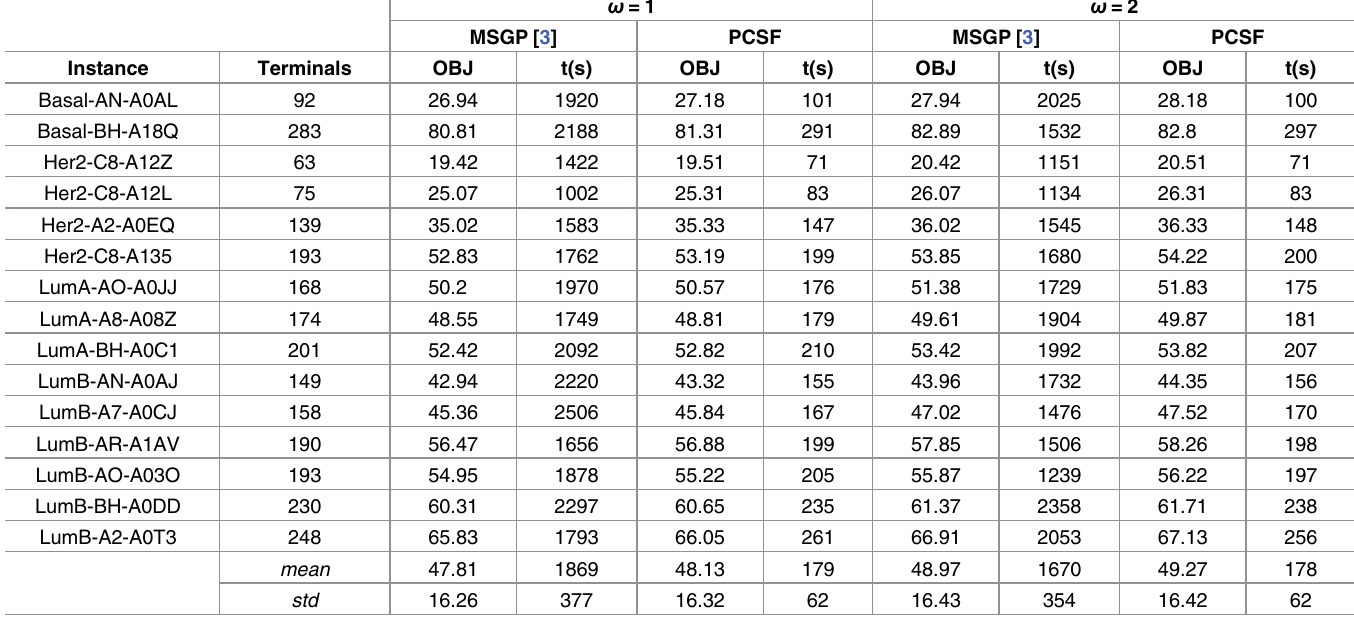
Table 1. The results of the methods for the BreastCancer network instances generated using the phosphoproteomic data in [11]. The performance of the message passingalgorithm[3] and the proposedmethod are respectivelydisplayedunder MSGP [3] and PCSF for ω = {1, 2}. The OBJ column reports the qualityof the solutions(objectivefunction values)obtainedby the methods, and the runningtimes of the algorithms are displayedunder t(s) in seconds. The averagestatistics of 10 runs providedby both algorithmsare reported for each instance. ω =